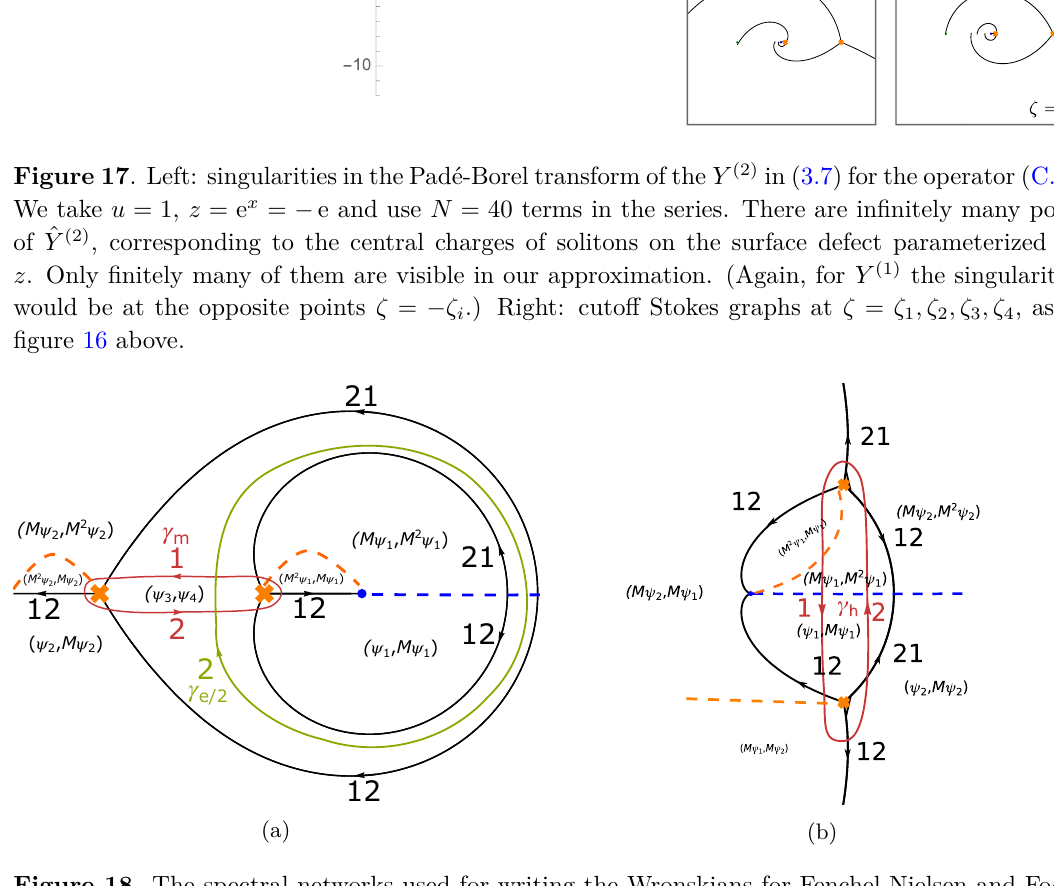
Figure 18 . The spectral networks used for writing the Wronskians for Fenchel-Nielsen and Fock- Goncharov coordinates. The Seiberg-Witten curve is given in (C.1). In figure 18a we choose Λ = 1 , u = − 9 / 8 . In figure 18b we choose Λ = 1 , u = 13 / 20